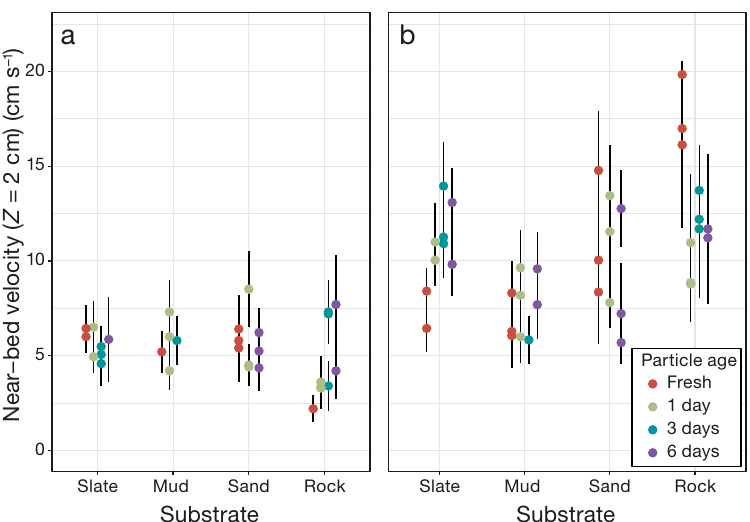
Fig. 2. Near-bed velocities for the onset of (a) particle saltation and (b) par- ticle resuspension. Dots indicate the mean velocity per replicate, while the error bars indicate standard deviations from the mean segment